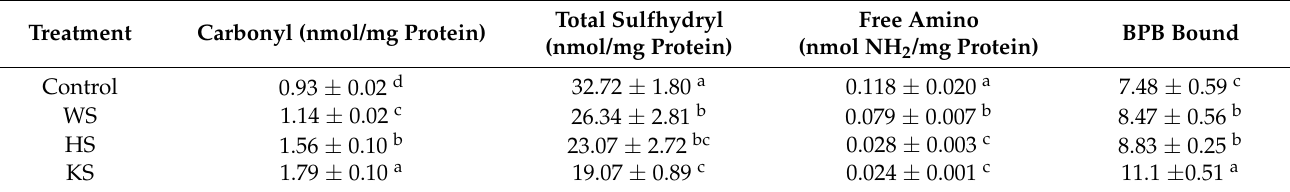
Table 2. Physicochemical changes of surimi protein with different